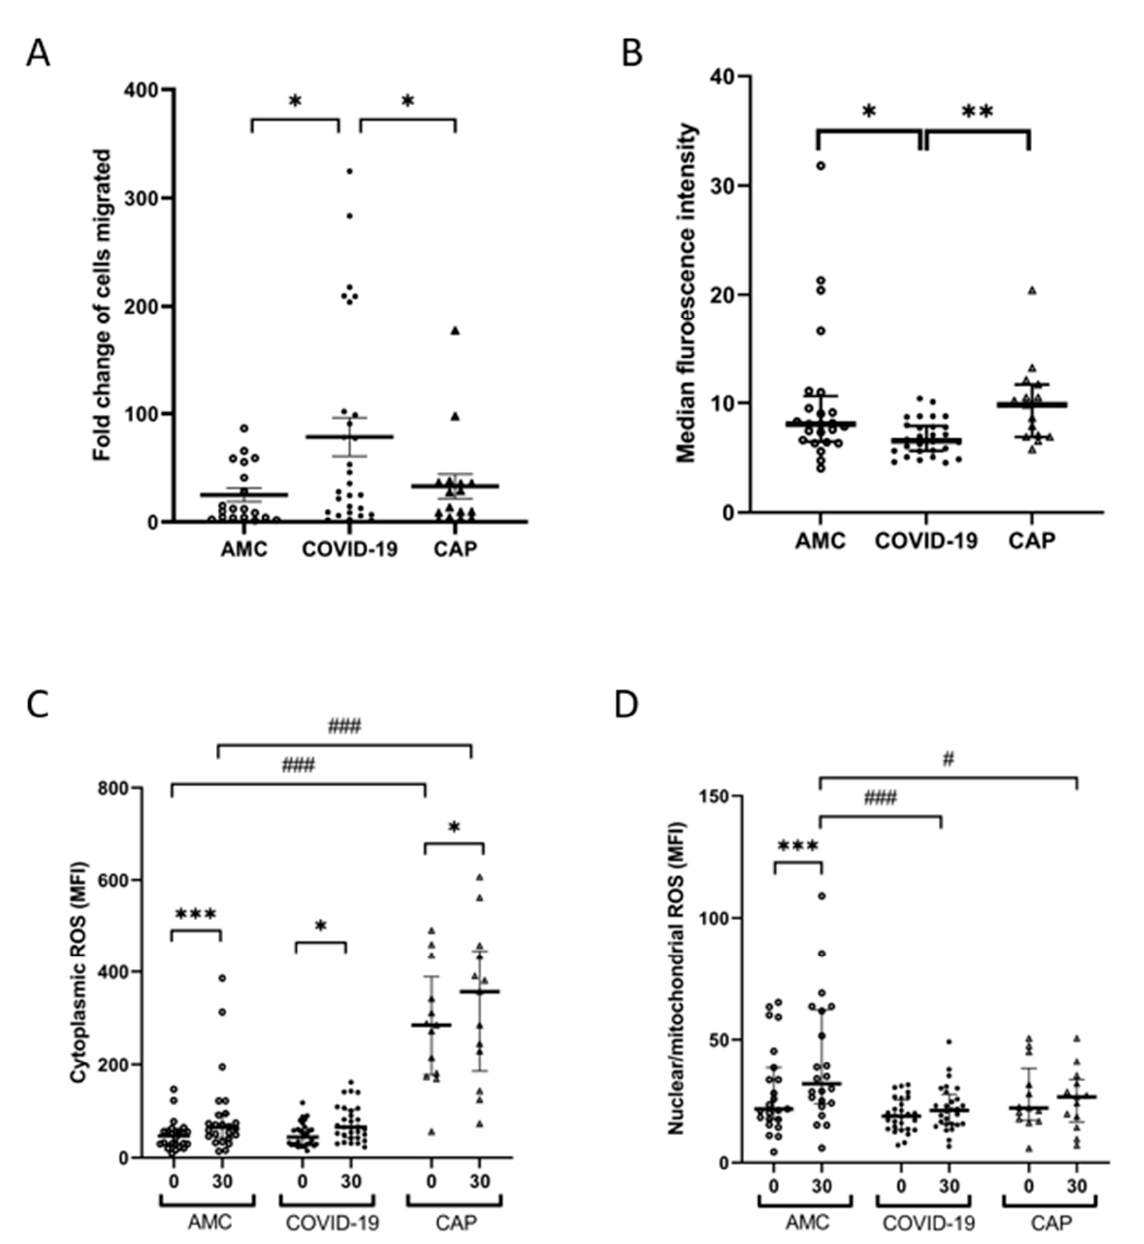
Figure 2. Neutrophil functional responses in COVID-19. ( A ) Neutrophil transmigration towards CXCL-8. Data shows fold change in neutrophils migrated to CXCL-8 compared to vehicle control. * p = 0.0332 AMC (n = 18) vs. COVID-19 (n = 28), * p = 0.0332 CAP (n = 10) vs. COVID-19 (n = 28). ( B ) Neutrophil phagocytosis of opsonized S. pneumoniae following a 30-min incubation. Data shows MFI of positive neutrophils. * p = 0.0366 AMC (n = 24) vs. COVID-19 patients (n = 30), ** p = 0.0052